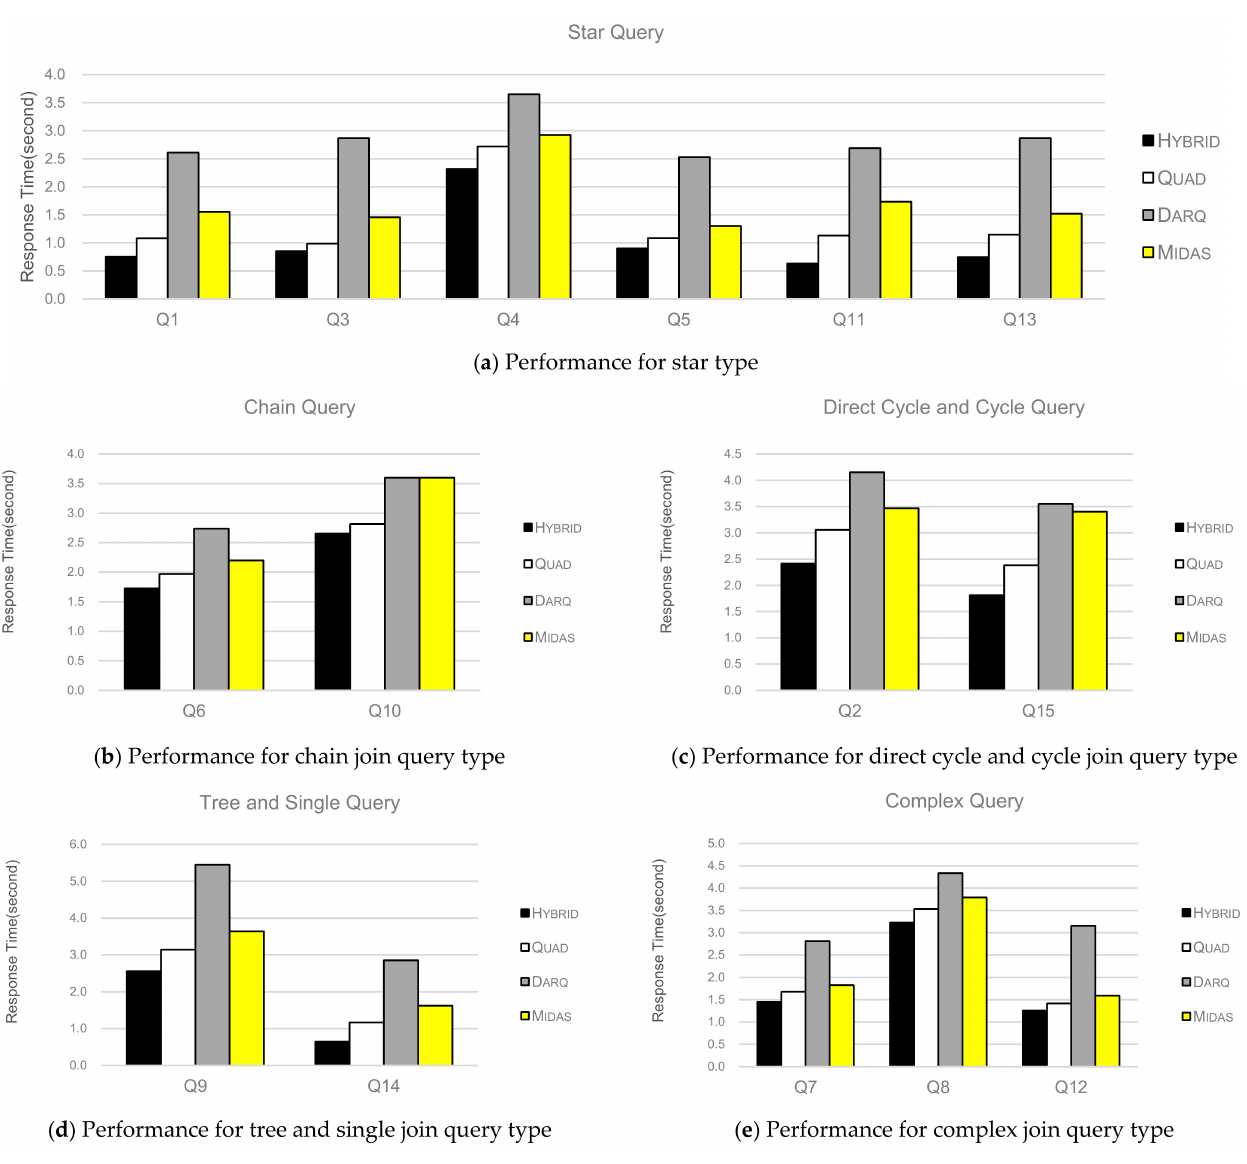
Figure 10. Join query performance for various join